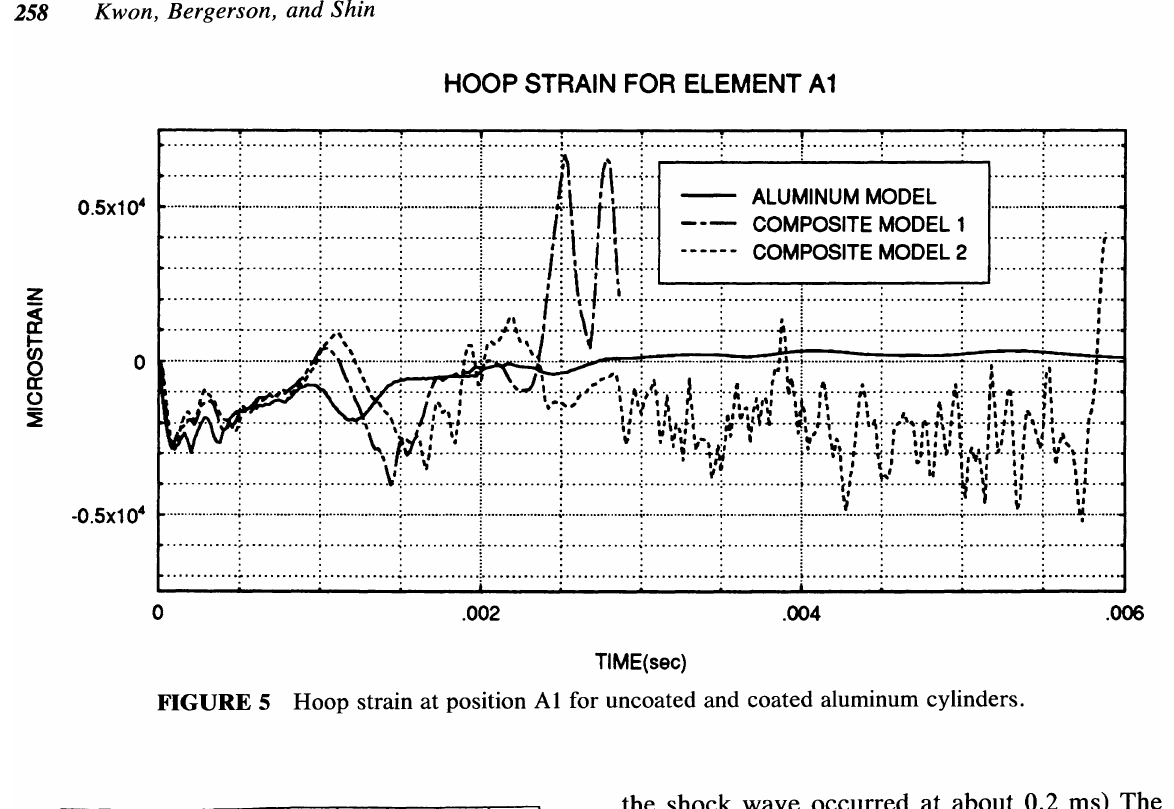
FIGURE 5 Hoop strain at position Al for uncoated and coated aluminum cylinders.